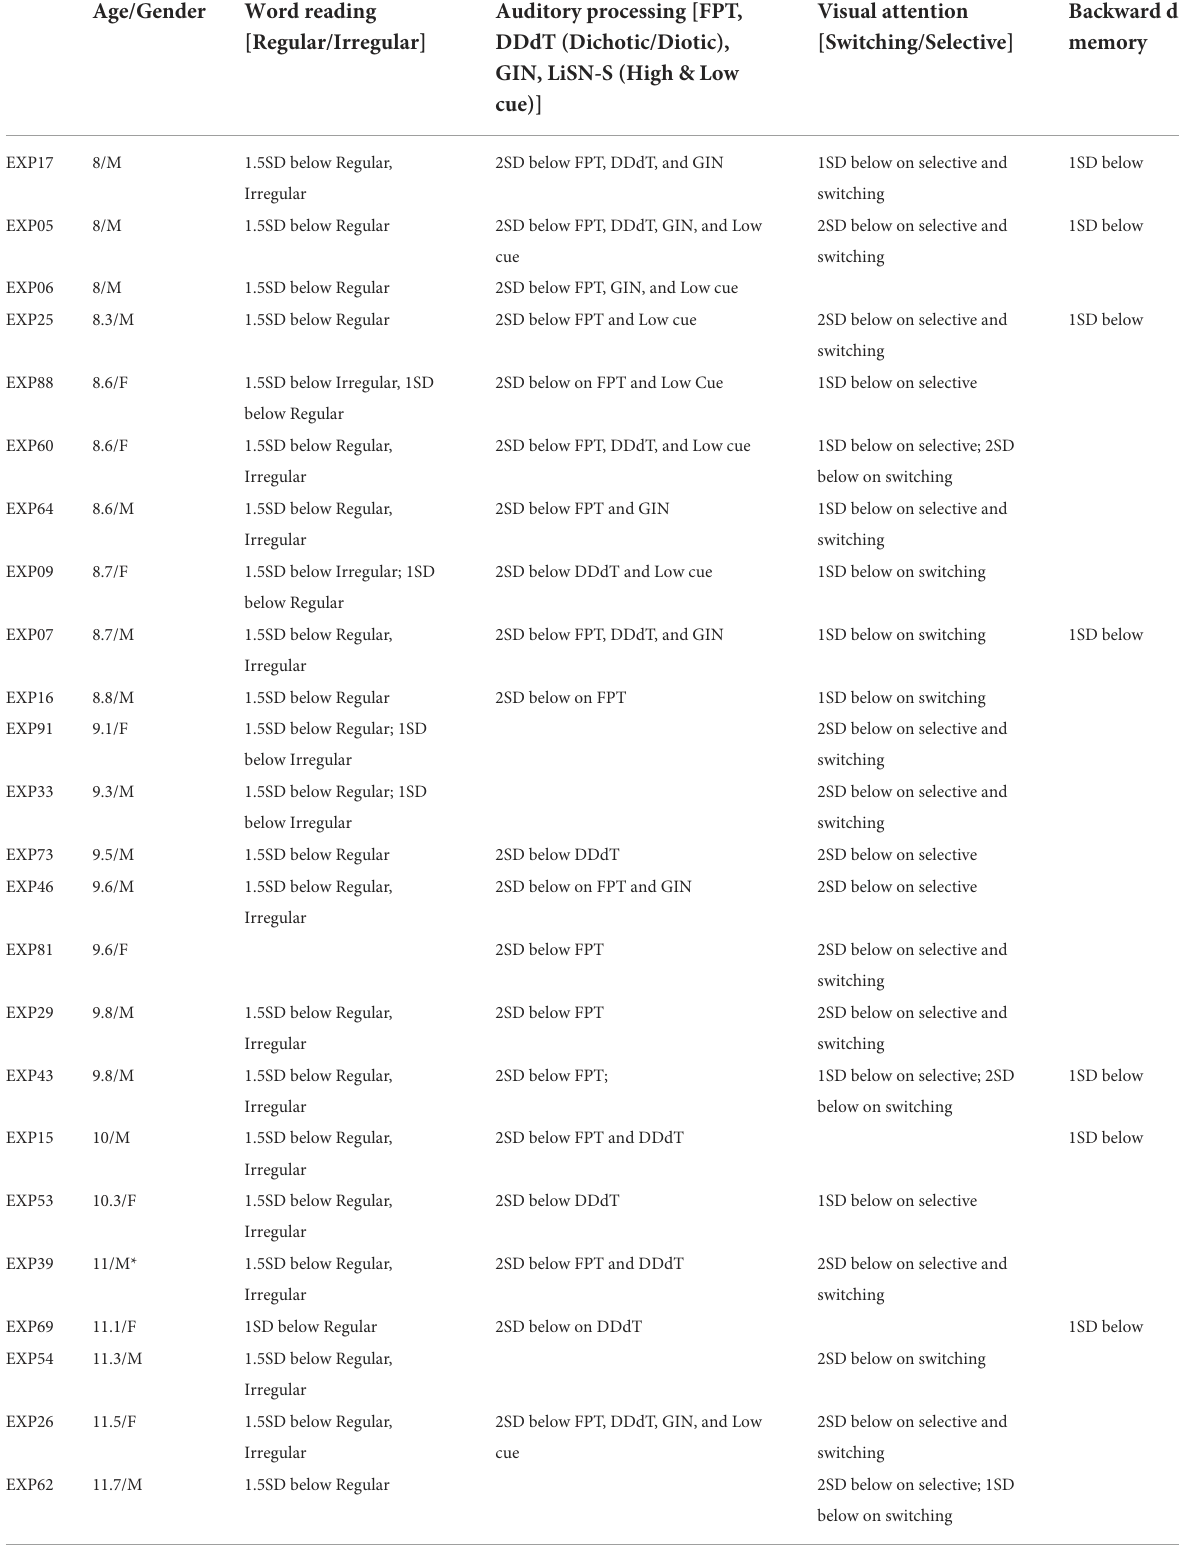
Visual attention Backward digit [Switching/Selective]